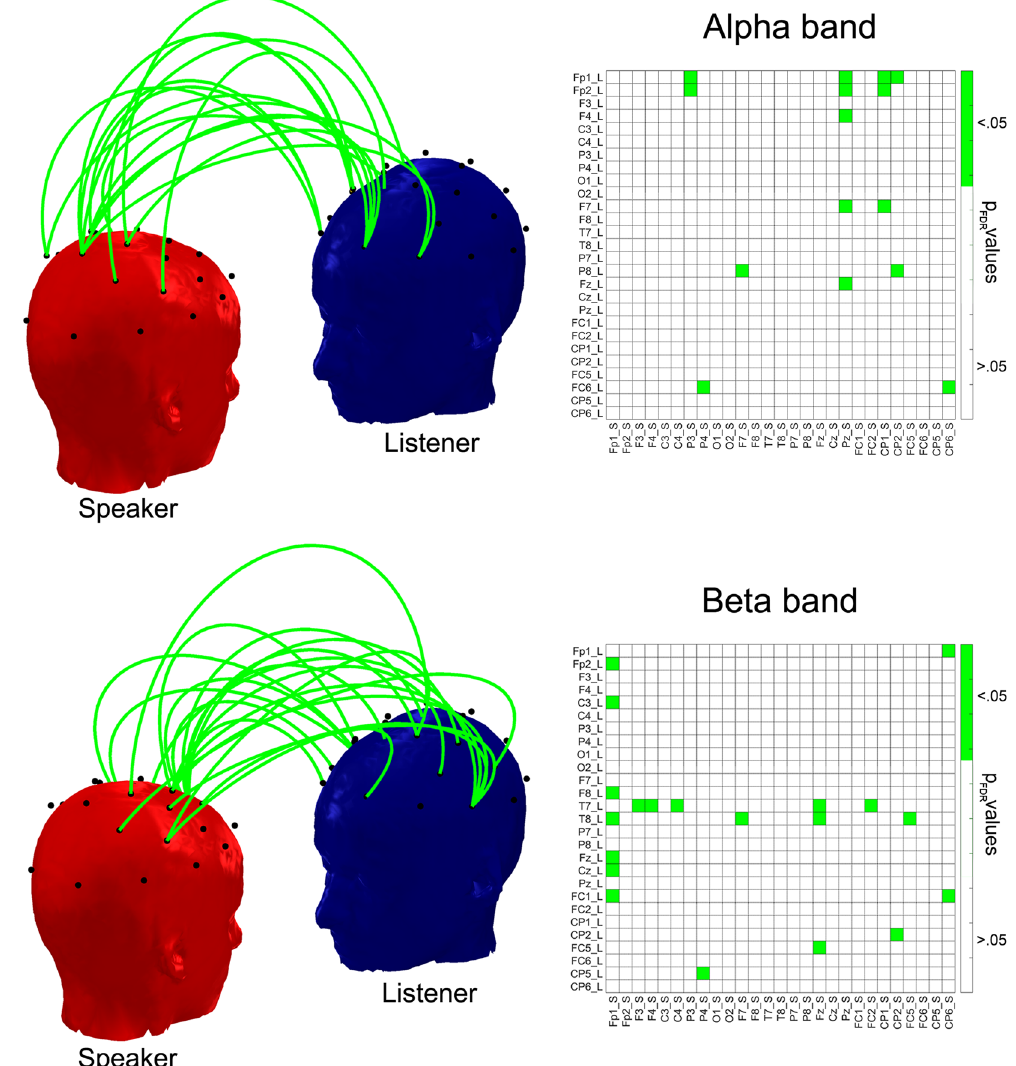
Figure 4. Representation of statistically significant enhanced interbrain synchronization patterns between the listeners and the speakers during oral narratives that are not explained by brain-audio envelope synchronization. Matrices on the right are those reported for group statistics on the interbrain synchronization patterns provided in Fig. 1, after deleting those electrode combinations where brain-to-brain synchronization is explained by the brain-audio envelope synchronization and after deleting electrode combinations that contain at least one electrode showing entrainment to speech. The plots on the left are an alternative representation of the information contained in the matrices. The red head represents the Speaker and the blue head represents the Listener, with the green lines connecting those electrode pairs that show significant enhancement in synchronization. In the alpha band (upper panel) the sites showing interbrain coupling are mainly frontal for the Listener and central for the Speaker. In the beta band (lower panel) the sites are mainly frontal for the Speaker and temporal for the